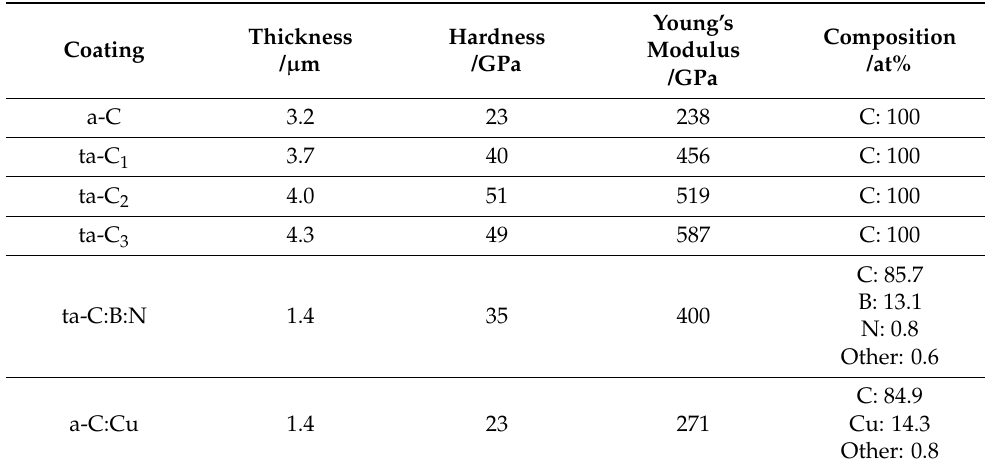
Table 1. Overview of tested amorphous carbon coatings, including thickness, hardness, Young’s modulus and composition.